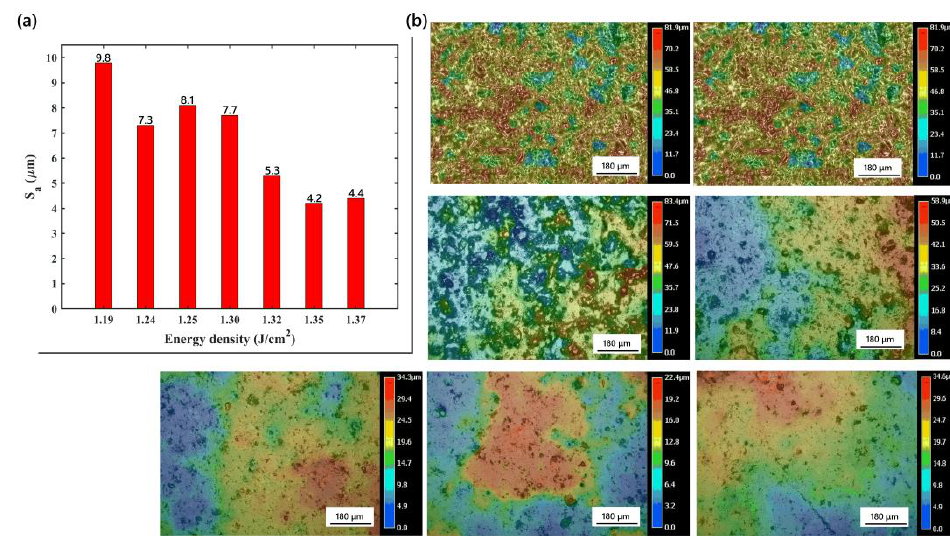
Figure 5. ( a ) The surface roughness (S a ) of printing samples. ( b ) Surface height maps with different laser energy densities. The energy densities from the first map to the last map are 1.19, 1.24, 1.25, 1.30, 1.32, 1.35, and 1.37 J/cm 2 .